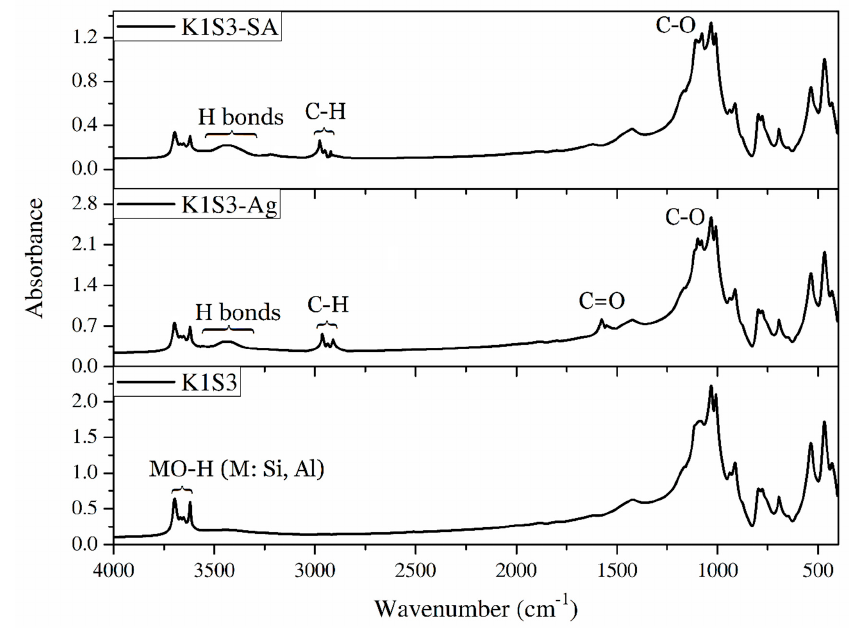
Figure 13. FTIR analysis of treated K1S3 using agar and sodium alginate.